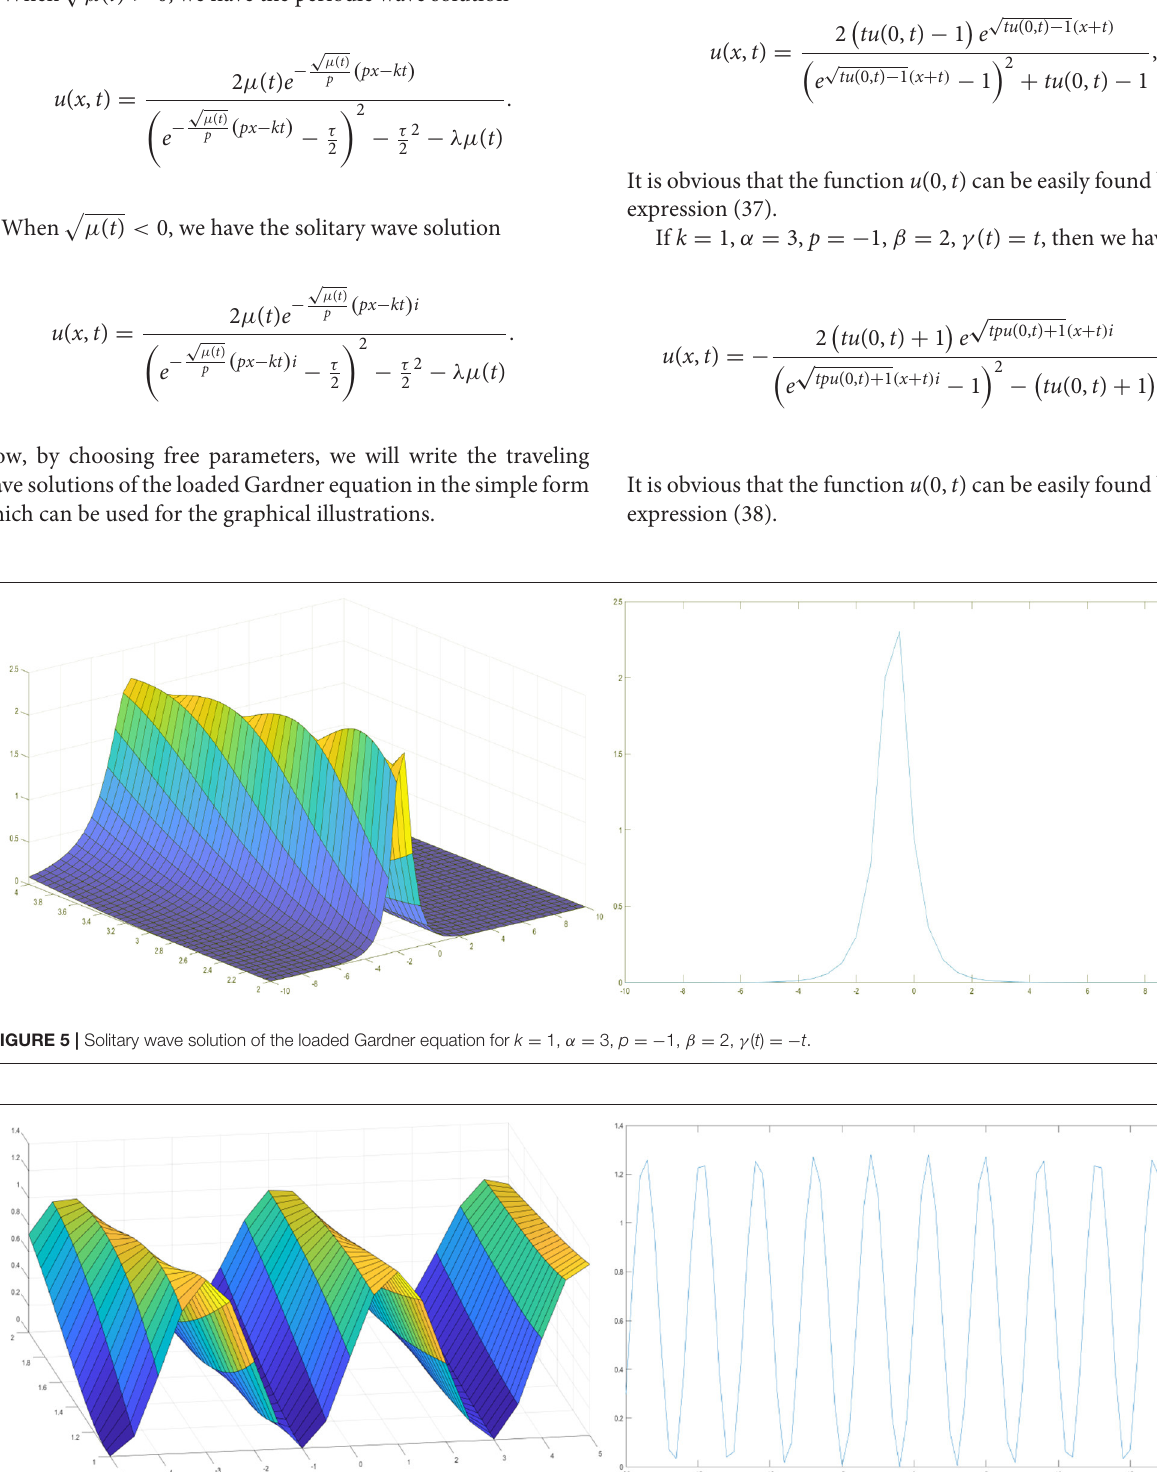
FIGURE 6 | Periodic wave solution of the loaded Gardner equation for k